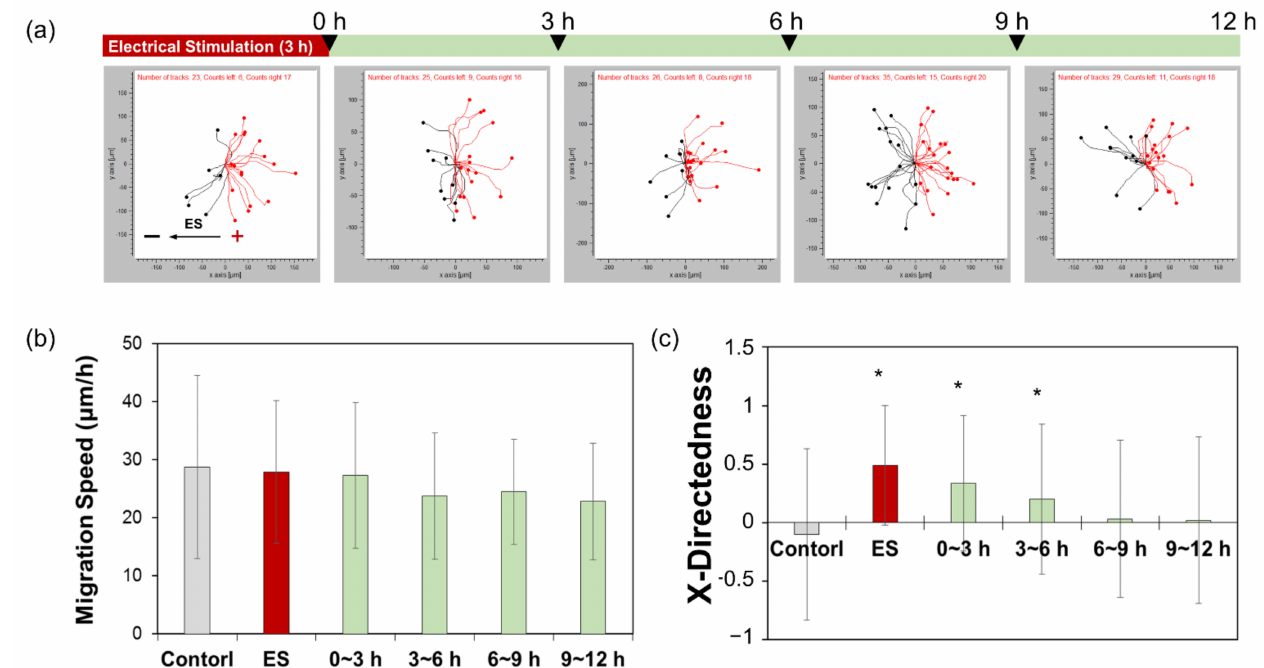
Figure 3. Migration assay of ADSCs subjected to single-round electrical stimulation (ES) for 3 h, followed by no stimulation. ( a ) Cell tracking data, ( b ) migration speed, and ( c ) X-directedness were determined for ADSCs subjected to 1200 µ A ES for 3 h, followed by no ES for 12 h. * represents p < 0.05 compared to controls not exposed to electric